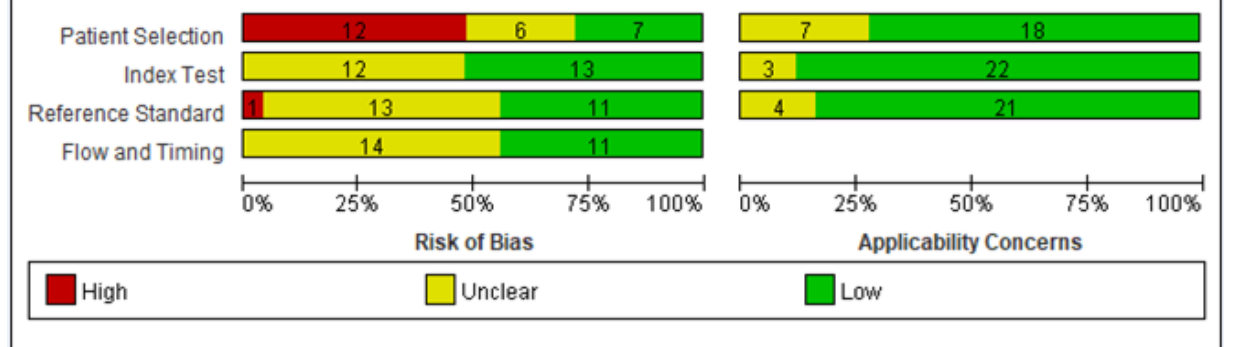
Figure 3. Quality assessment of Diagnostic Accuracy Studies 2 (QUADAS-2) study quality sum- mary.